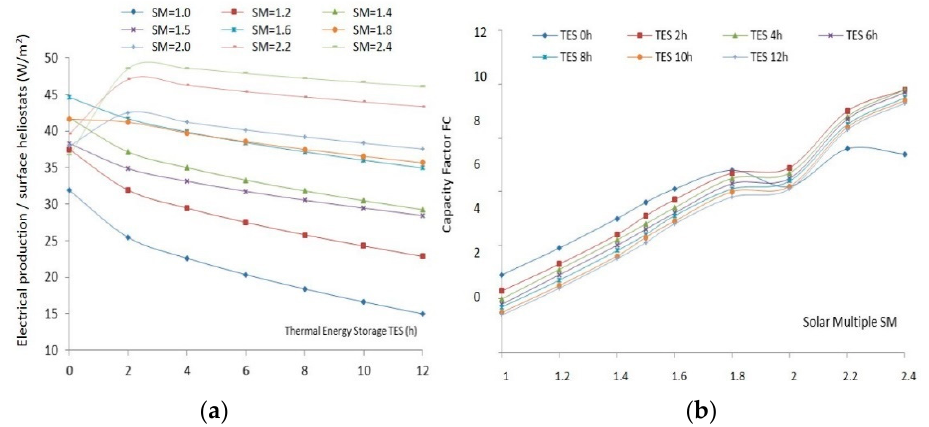
Figure 4. ( a ) Effect of Thermal Energy Storage ( TES) on electrical production/m 2 (surface heliostats) under different values of solar multiple (B é char). ( b ) Solar multiple effect on capacity factor ( CF ) under different TES values (B é char).